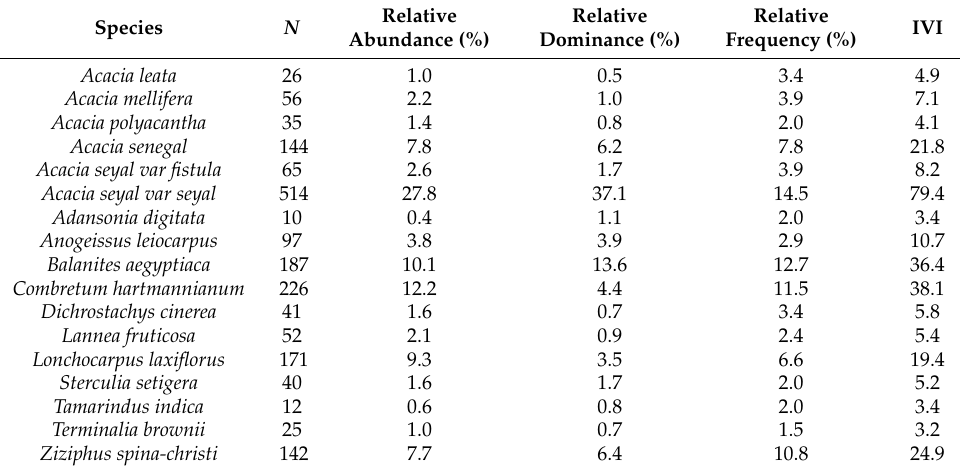
Table A1. Total number, relative abundance, dominance, frequency and IVI of the tree species counted and measured in the disturbed site in the Dinder Biosphere Reserve.